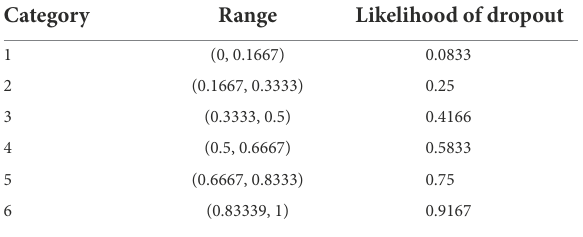
TABLE 3 Scores transferred to a likelihood of dropping out.